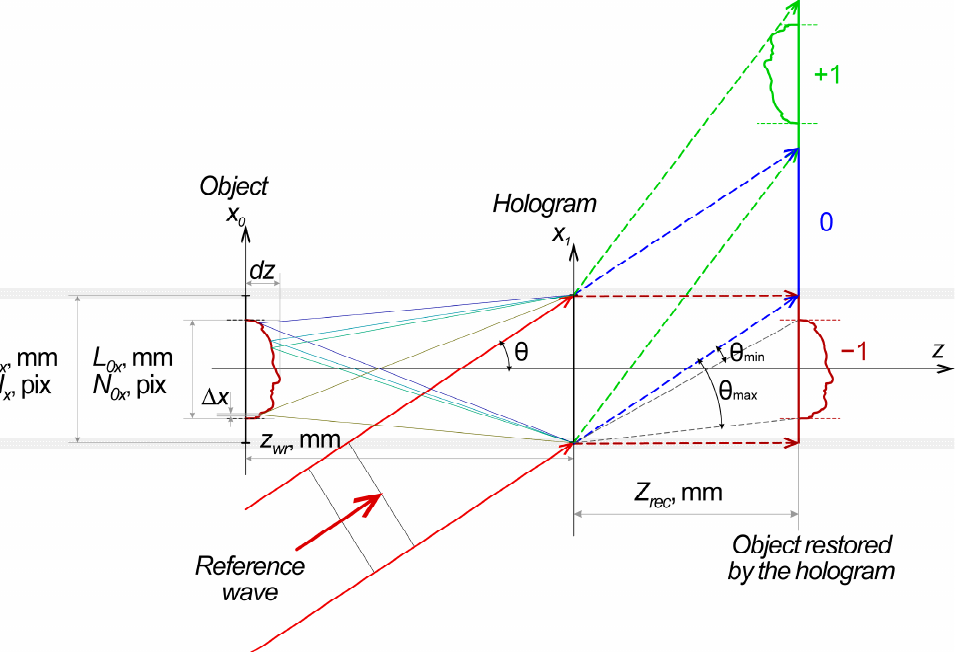
Figure 1. Schematic synthesis of a digital discrete hologram: x 0 —object plane; x 1 —hologram plane; z —the direction of object wave propagation; L 0 x —object width, mm; N 0 x —object width, pixels; θ —the incident angle of the reference wave creating the spatial carrier frequency of the hologram; θ min —the minimal spatial carrier deviation angle formed by the object; θ max —the maximal spatial carrier deviation angle formed by the object; L x —the object fi eld width, mm; N x —the object fi eld width, pixels; ∆ x —discrete (pixel) width; dz —object depth; z wr —distance between the object base and the hologram; and z rec —the distance between the hologram and the restored image.